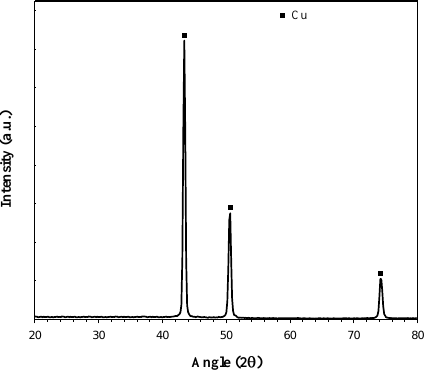
Figure 9. XRD patterns of deposited Cu product on the cathode at optimal